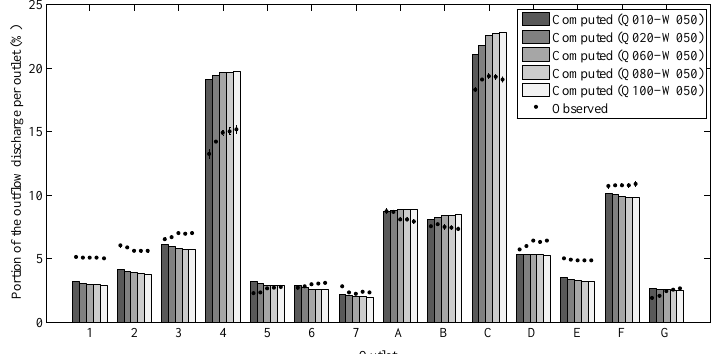
Figure 3. Observed and computed contributions of each street to the total outflow discharge for five different inflow